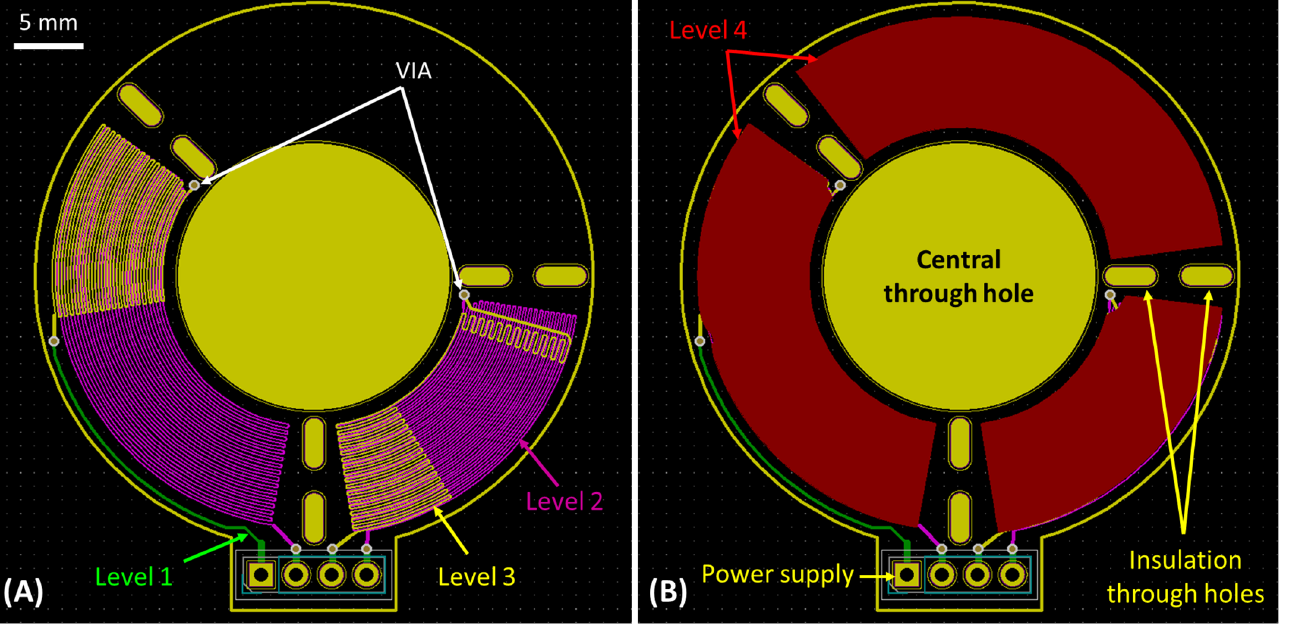
Figure 7. The geometry that achieved the best results in the computational study (3rd microreactor) was designed for fabrication in PCB, with the use of KiCad software program (5.1.0). On the left ( A ), the integrated microheaters can be seen at copper layers 2 (violet) and 3 (yellow) of the PCB. In the first and lower copper layer (green), the microheaters are connected to the temperature controller. The layers are interconnected at specific points with vertical interconnect access (VIA) elements. On the right ( B ), three solid copper layers are shown in red. These copper layers are located above each temperature zone (layer 4) to provide improved temperature uniformity.